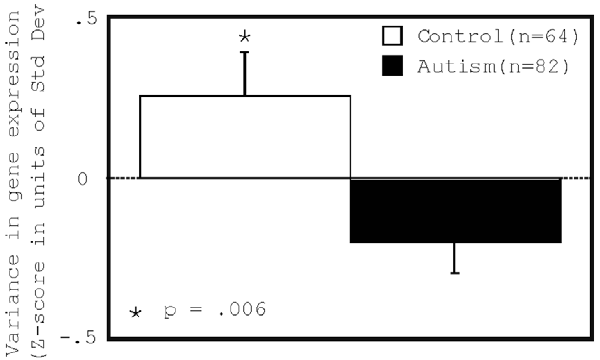
Figure 2. Overall variance in gene expression in peripheral blood lymphocytes (PBL) was decreased in children with autism. We used microarrays to measure the expression levels of greater than 47,000 transcripts including 38,500 well-characterized human genes using the Affymetrix Human U133 Plus 2.0 microarray on RNA from peripheral blood lymphocytes from each of 82 children with autism and 64 control subjects. Microarrays showed no group level differences in quality control measures. Microarray expression levels were log-transformed and the overall variance was calculated across the total distribution of expression levels on each microarray. Variance in gene expression was significantly decreased in the blood of children with autism (p=.006). Error bars represent standard